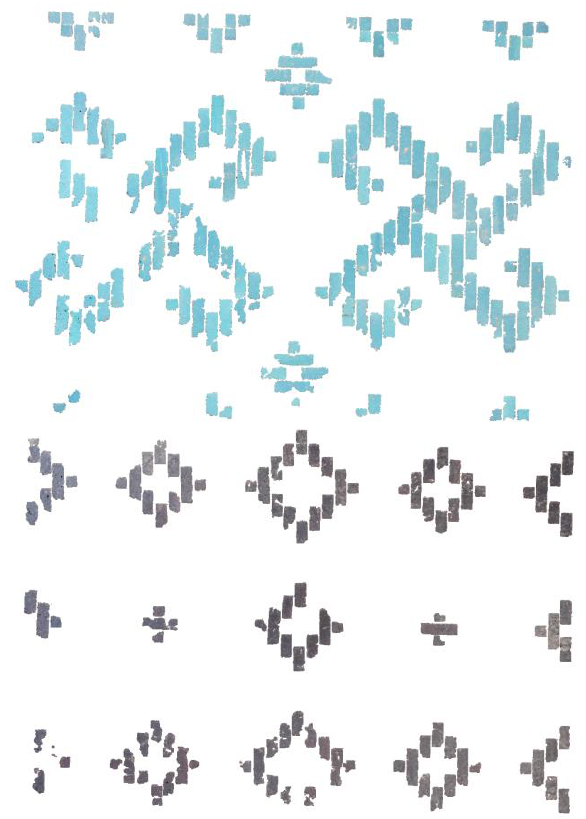
Figure 8. Filtered turquoise bricks (top) and black bricks (bottom) of the wall in Sırçalı